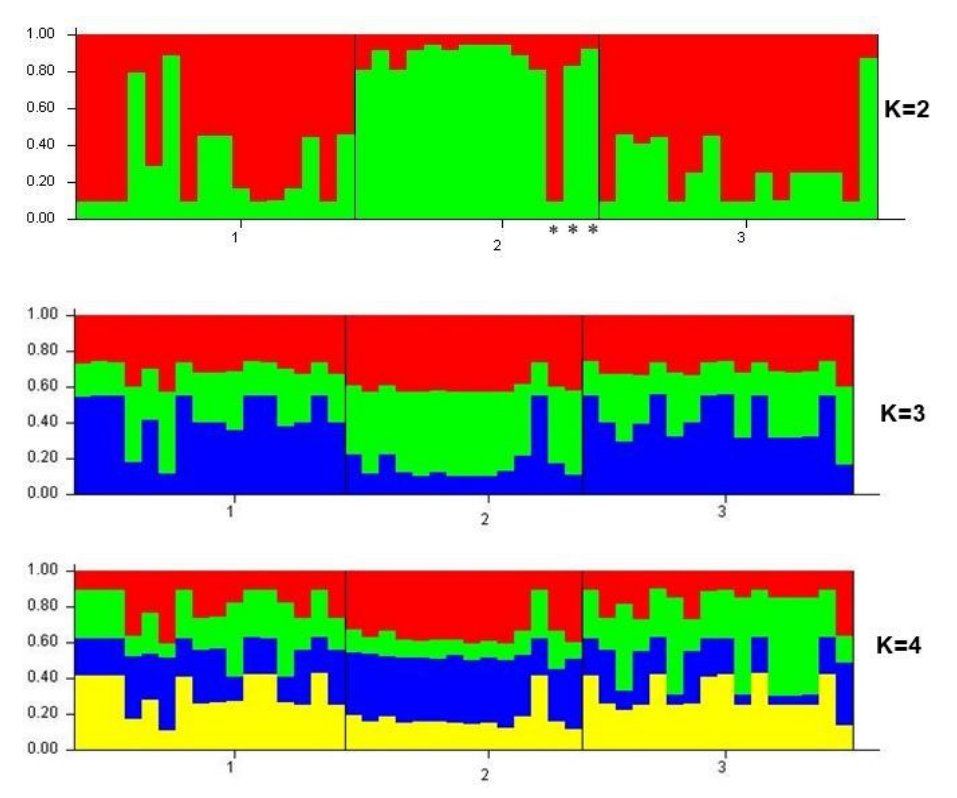
Figure 3. The genetic structure of the studied Apis cerana samples: 1—sample from South Korea, 2—samples from Vietnam (subspecies A. c. indica , except for specimens marked *— A. c. cerana ) and 3—samples from the Russian Far East. K is the inferred number of clusters.